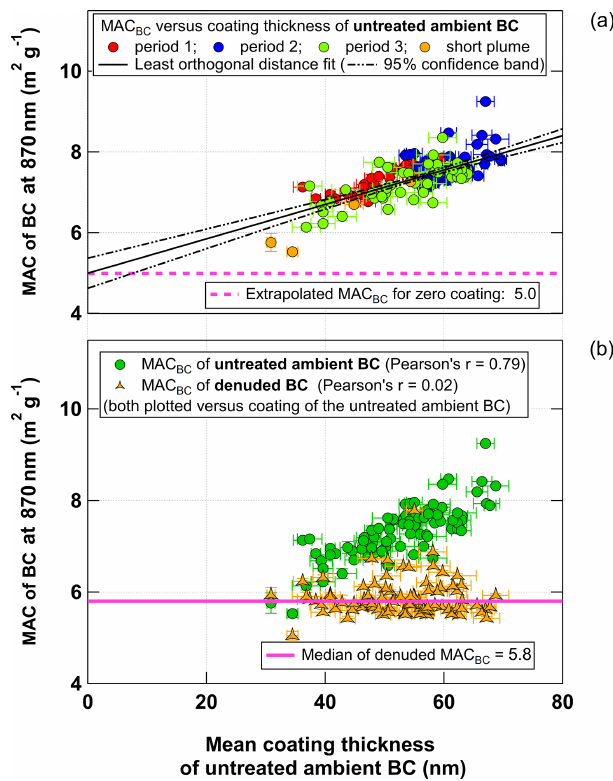
Figure 6. (a) MAC BC of the aerosol sample dried to low RH against the mean coating thickness of ambient rBC particles with core diameters in the range 200–220nm mass equivalent diameter. (b) MAC BC of ambient and thermo-denuded samples against the mean coating thickness of ambient rBC particles. Each data point represents an average value over a 3h time period with error bars representing the standard error of the mean (these averages were performed with 1min resolution data in the case of the MAC BC values and 1s resolution data in the case of the mean coating thick- nesses). An orthogonal distance linear regression was applied to the ambient data to calculate a y -intercept value that represents an esti- mate of the MAC for zero coating, i.e., MAC BC , bare . Note that the number of ambient MAC BC data points in (b) is smaller than in (a) due to the gap of missing data in the denuded MAC BC time series from 7 to 14 February shown in Fig.